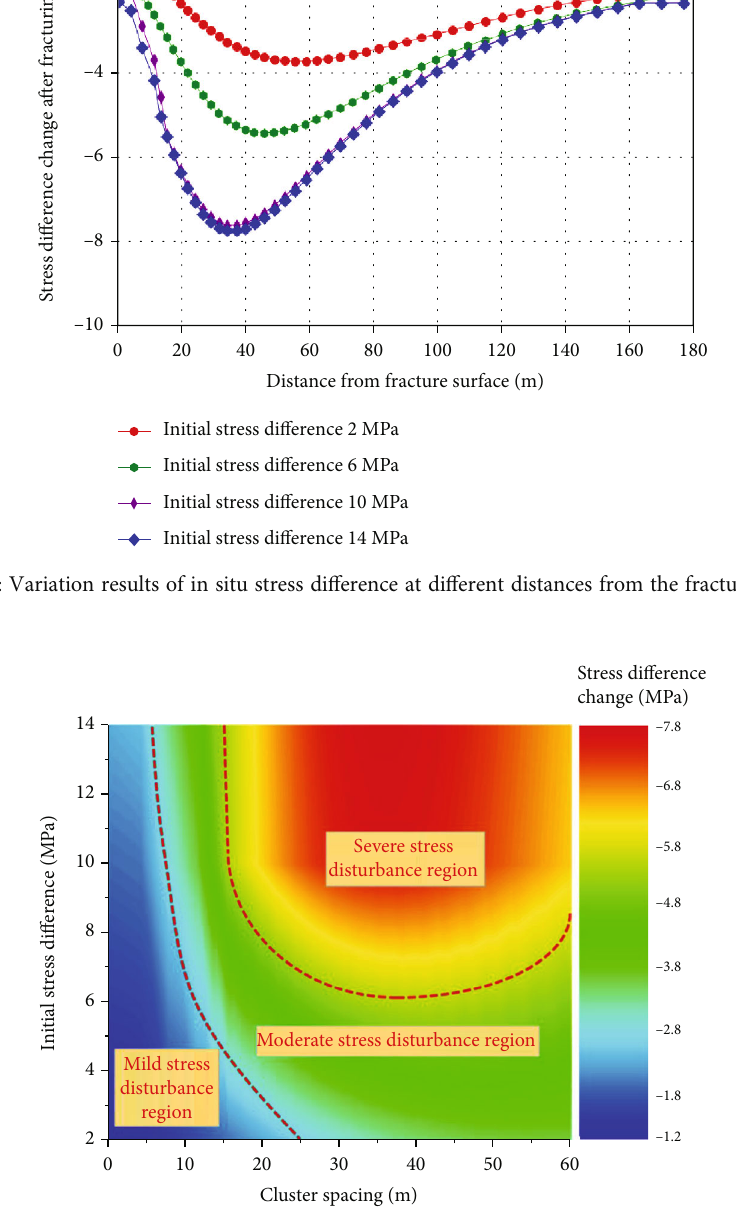
Figure 7: Stress disturbance limit chart used to describe variation of in situ stress di ff